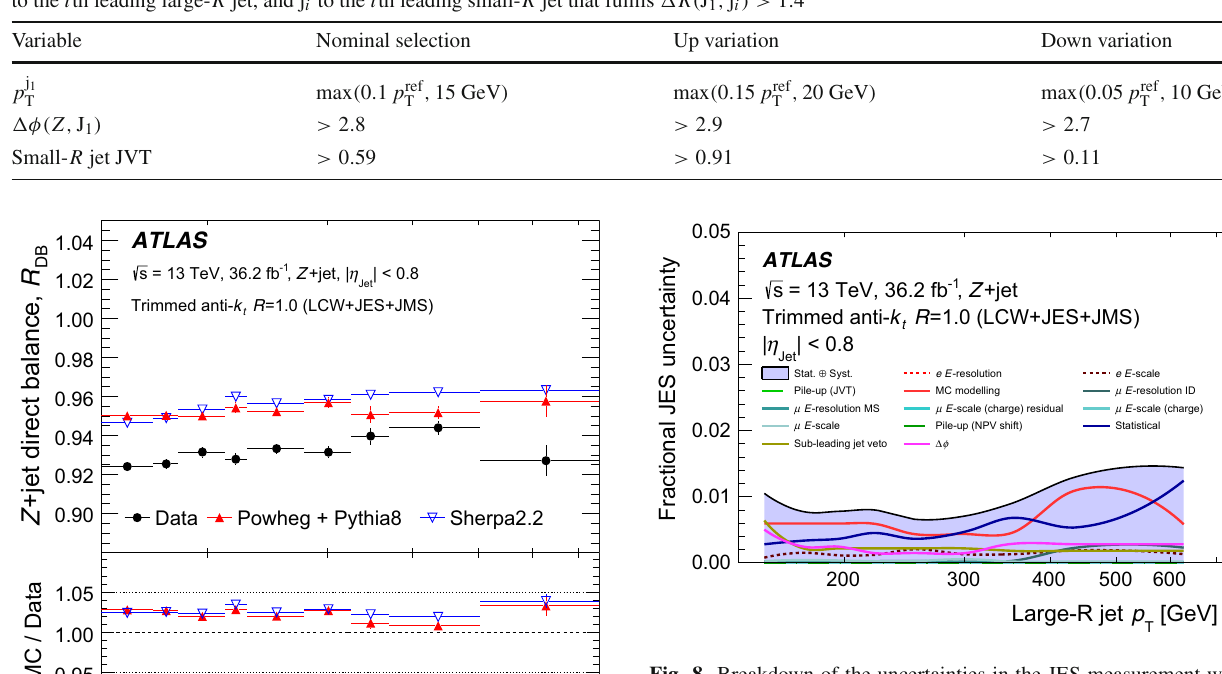
Fig. 8 Breakdown of the uncertainties in the JES measurement with the Z +jet direct balance method as a function of the large- R jet trans- verse momentum p T . The sources include the statistical uncertainty, variations of the generator (simulation modelling), variations of the event selection (pile-up (JVT), sub-leading jet veto, (cid:4)φ ), the uncer- tainties in the energy scale and resolution of electrons ( e E -scale and e E -resolution) and muons ( μ E -scale and μ E -resolution), and the uncertainty in the pile-up conditions ( N PV shift). These uncertainties are also discussed in the context of small- R jets in Ref. [9]. The lines T areobtainedbysmoothingabinnedrepresentationoftheseuncertainties using a sliding Gaussian kernel , 15 GeV ) . Small- R jets satisfies p T > max ( 0 . 1 p ref T